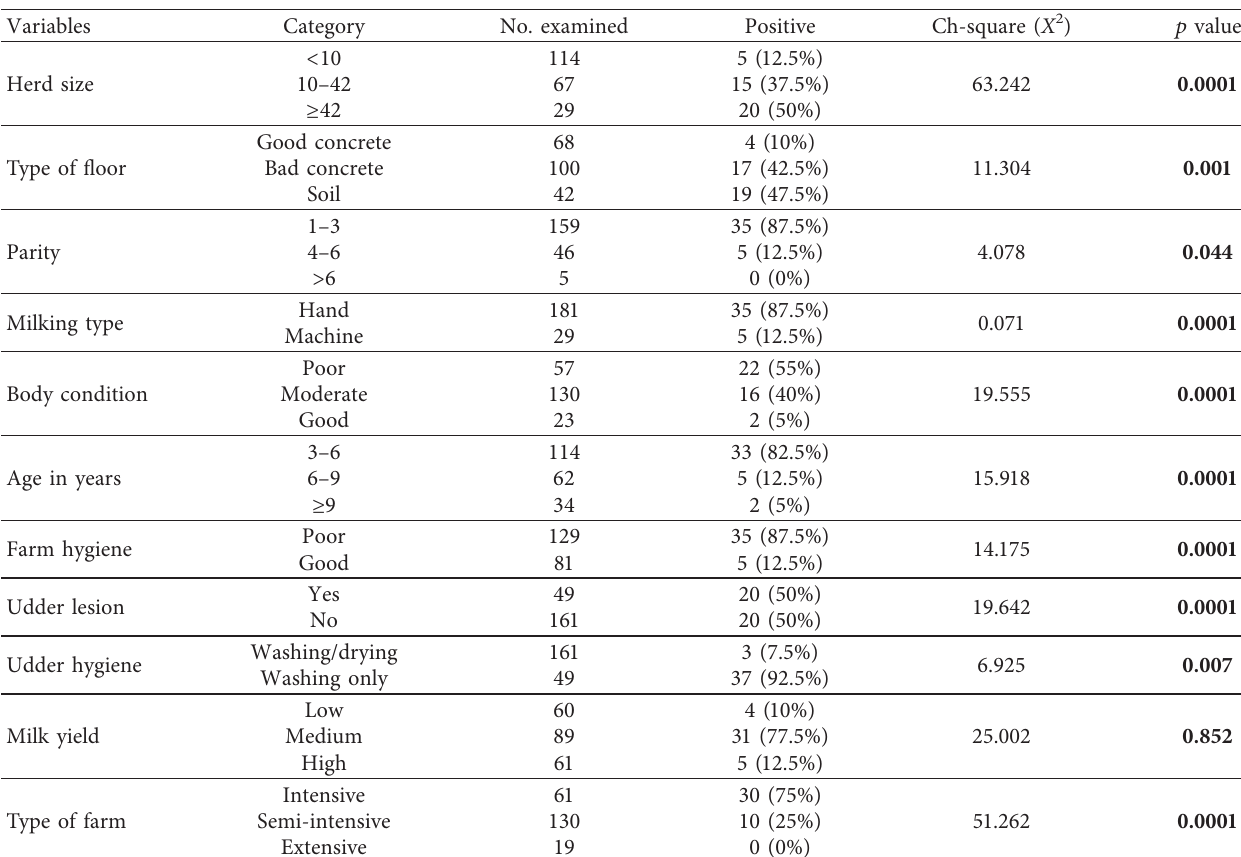
Table 2: Association of risk factors with the occurrence of E. coli O157 :H7 in the study area.